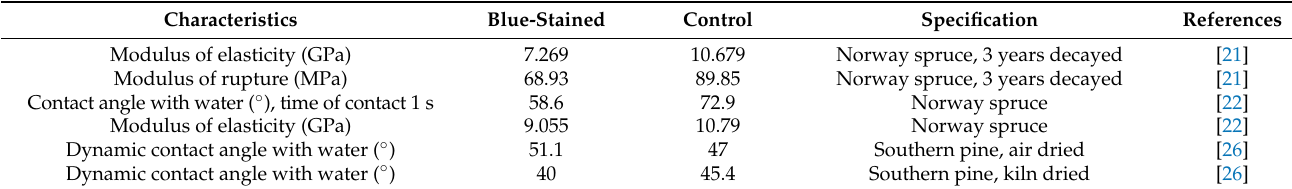
Table 1. Selected physical and mechanical properties of wood from beetle-attacked